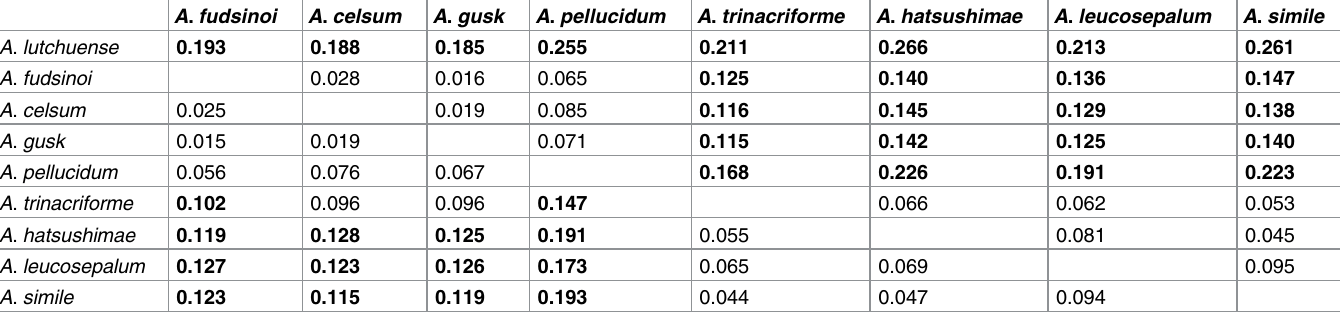
Table 3. Pairwise FST comparisons between nine Asarum species on Amami Group.